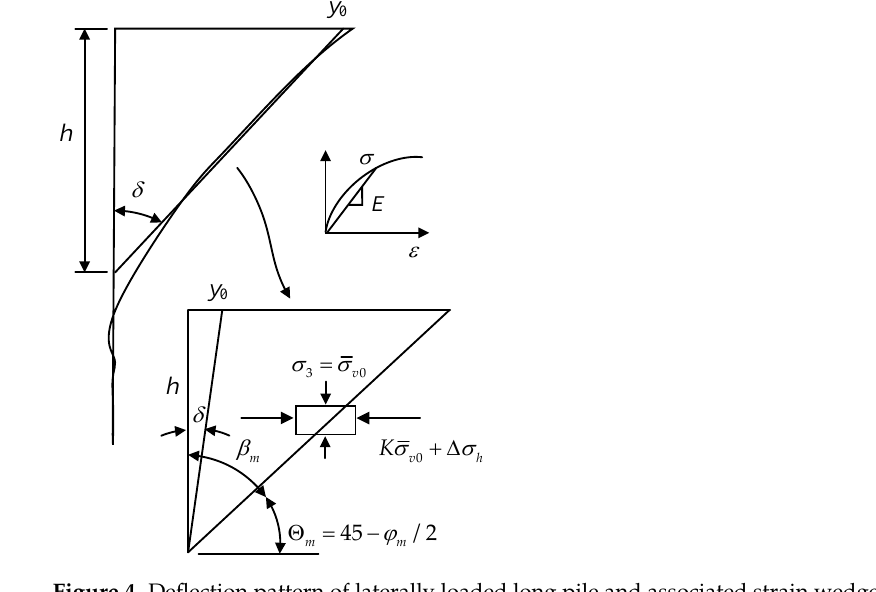
Figure 4. Deflection pattern of laterally loaded long pile and associated strain wedge (Modified from Ashour et al. [21]).